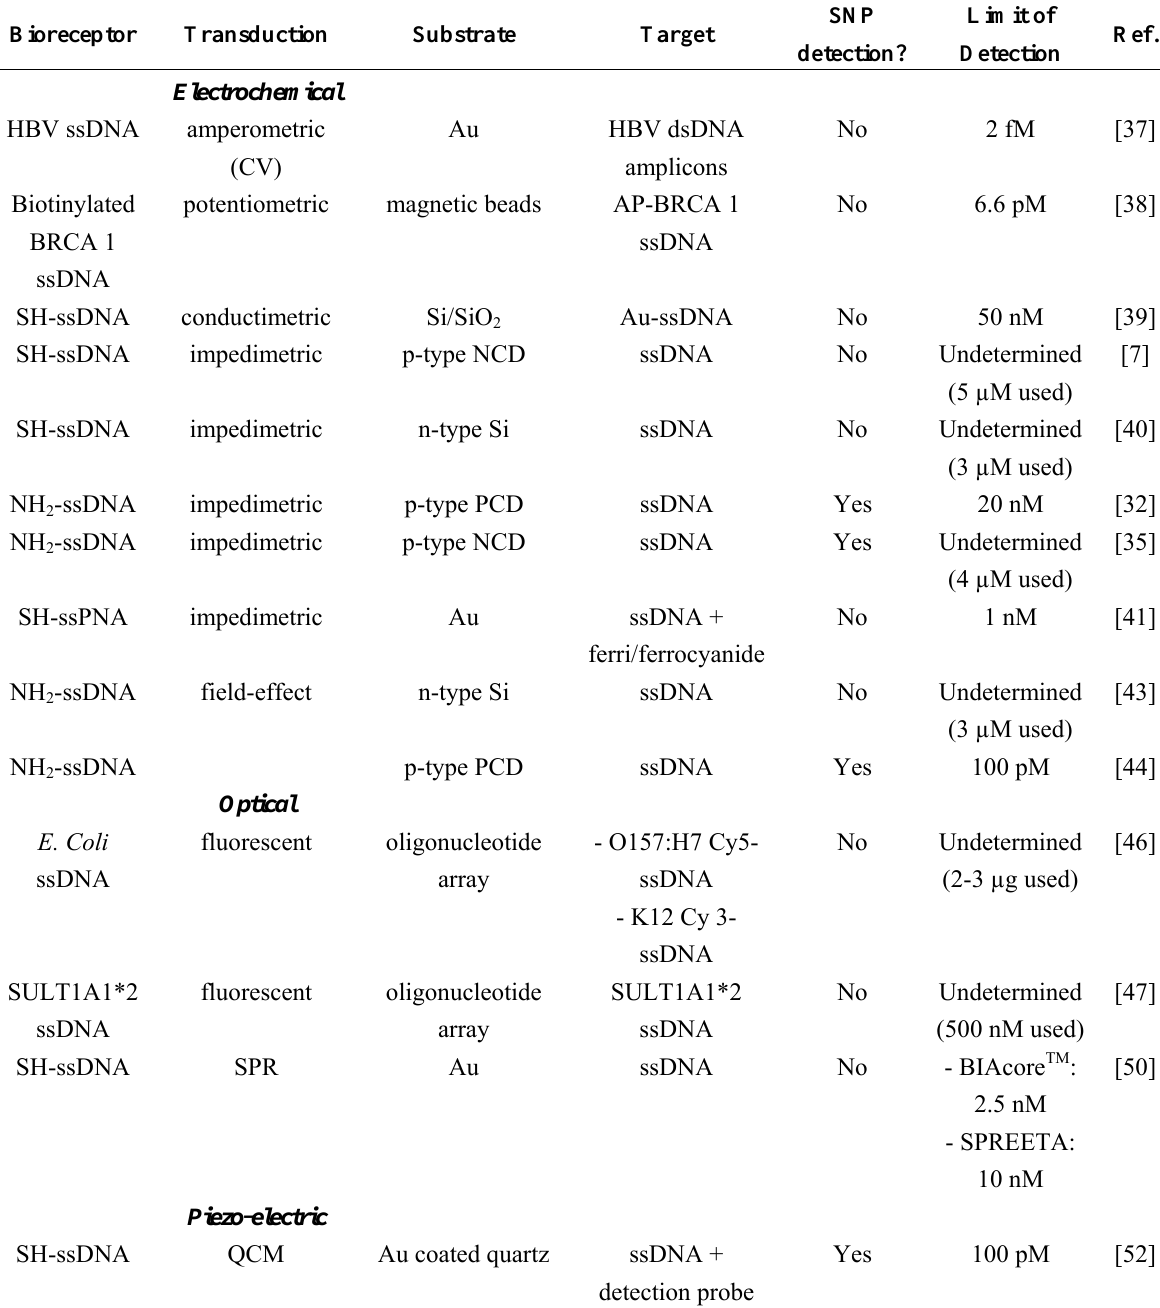
Table 4. Overview of biosensors, classified according to the transduction principle and biological receptor molecule, including key measurement